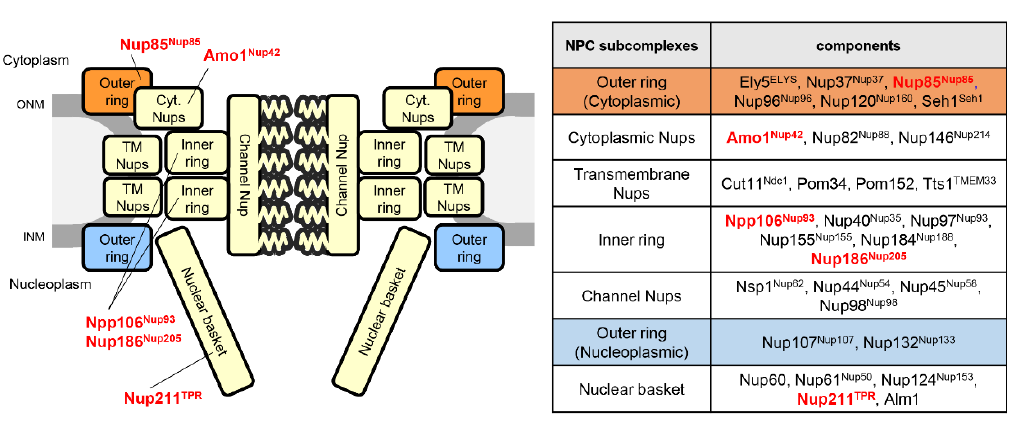
Figure 7. Subcomplex structure of the S. pombe NPC. ( Left ) Schematic drawing of the NPC. Nups described in the text are shown in red; human orthologs are written in superscript. TM Nup, transmembrane Nup; ONM, outer nuclear membrane; INM, inner nuclear membrane. ( Right ) NPC subcomplexes and their components.